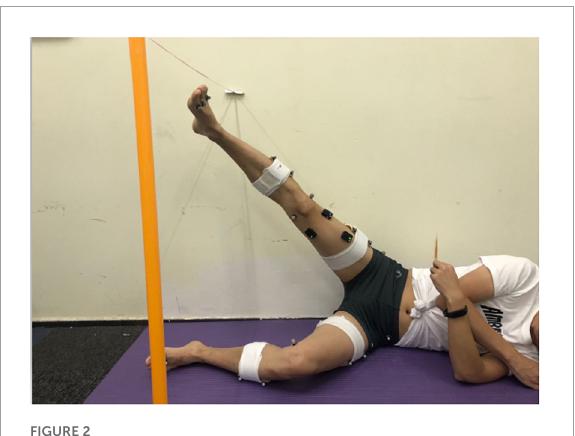
measured by surface electromyography (SEMG) over the fatigue